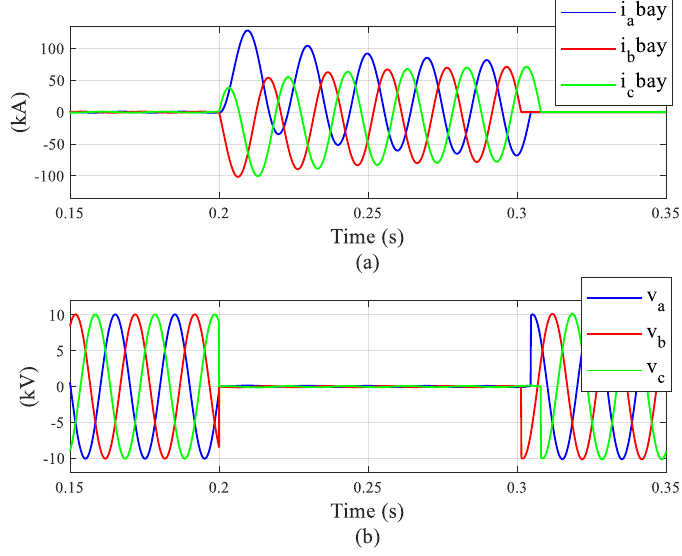
Figure 8. Three-phase fault in Load L1 without the PFCA. ( a ) Currents abc in circuit breaker (CB) of Load L1; ( b ) voltages abc in busbar.